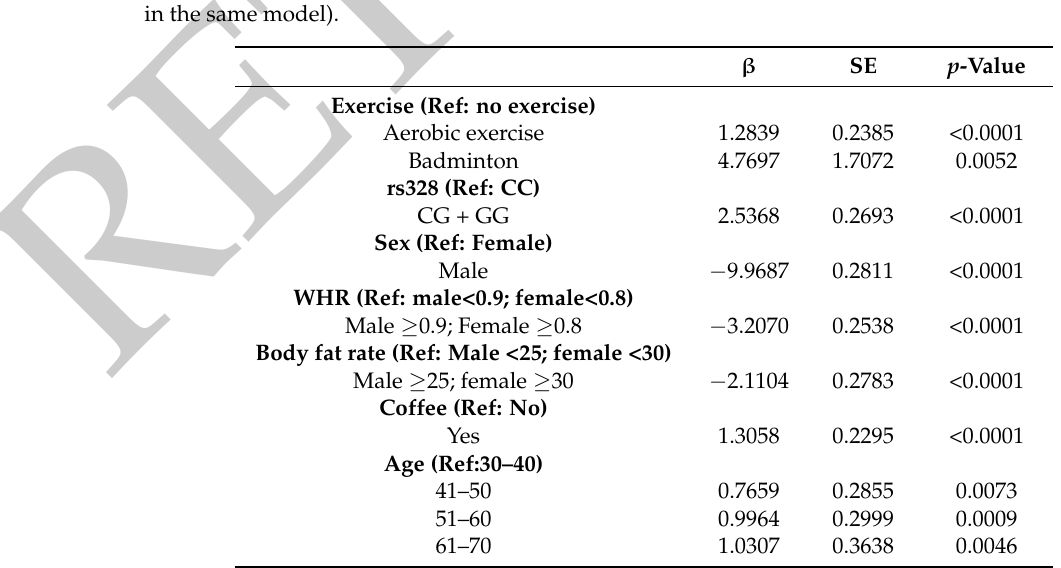
Table 3. Association between HDL-C and exercise type (aerobic exercise and badminton are included in the same